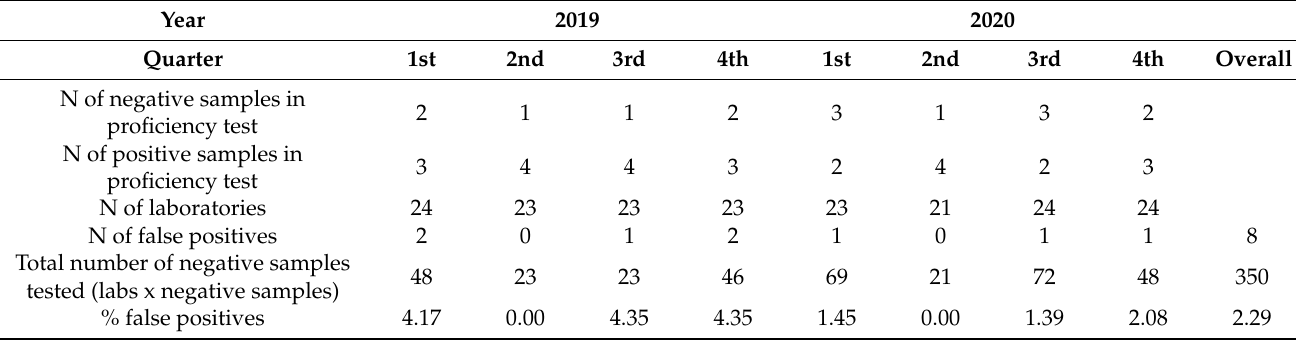
Table 2. Number (N) of Salmonella proficiency test results of NVWA-designated laboratories in the period 2019–2020, based on results from VETQAS proficiency tests (source: National Reference Laboratory for Salmonella , RIVM, Bilthoven, The